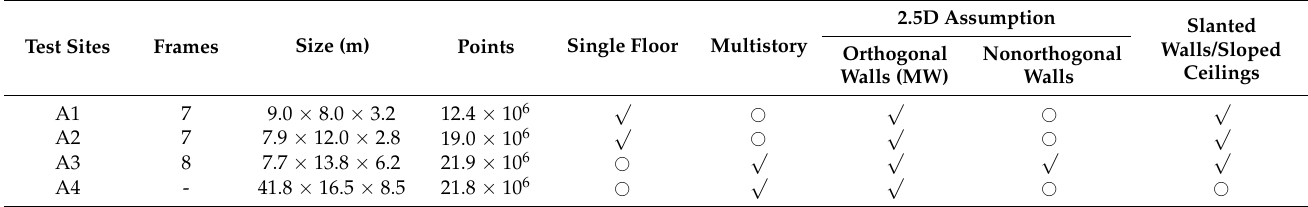
Figure 7. Experiments on point cloud datasets. From left to right: Original point cloud, room segmentation result, reconstructed room layout. Table 2. Detailed descriptions of the experimental point cloud